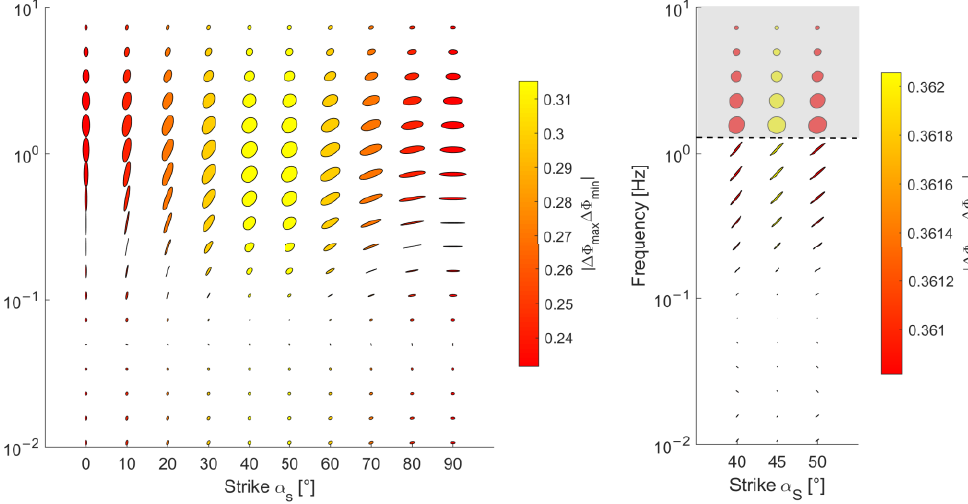
Figure 10. The residual phase tensor for different strike angles of the conductivity x-axis.